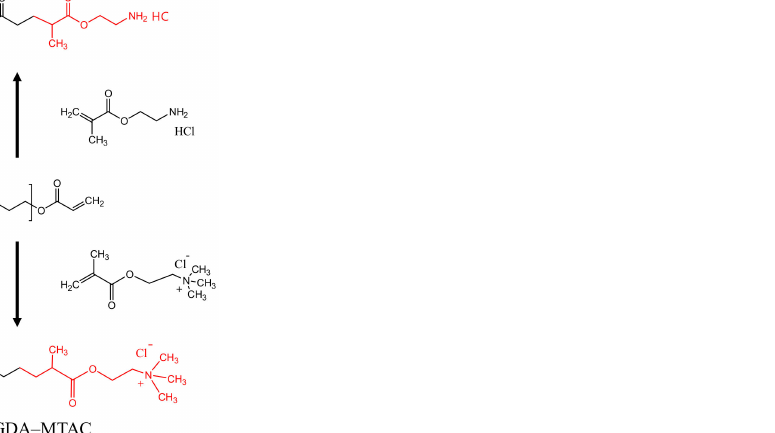
Figure 1. Synthesis of reusable hydrogel adsorbents ( a ) PEGDA–AMHC and ( b )